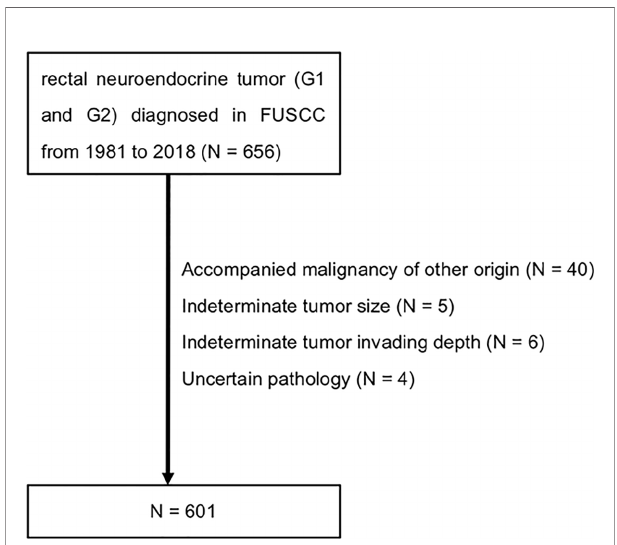
FIGURE 1 | Flowchart of the study population. FUSCC, Fudan University Shanghai Cancer